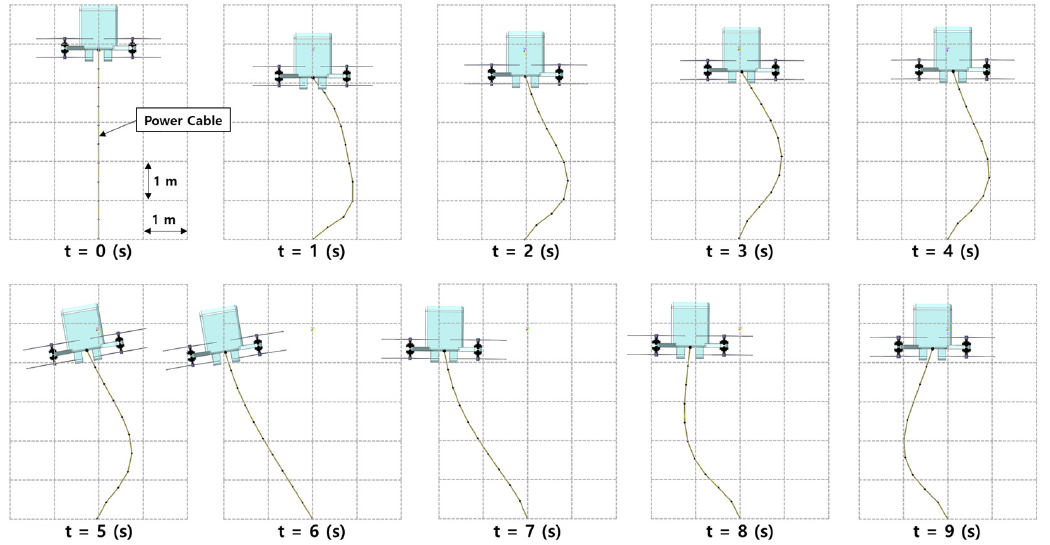
Figure 16. Front view of the tethered multicopter captured every second during roll maneuver control simulation at 5 m altitude.